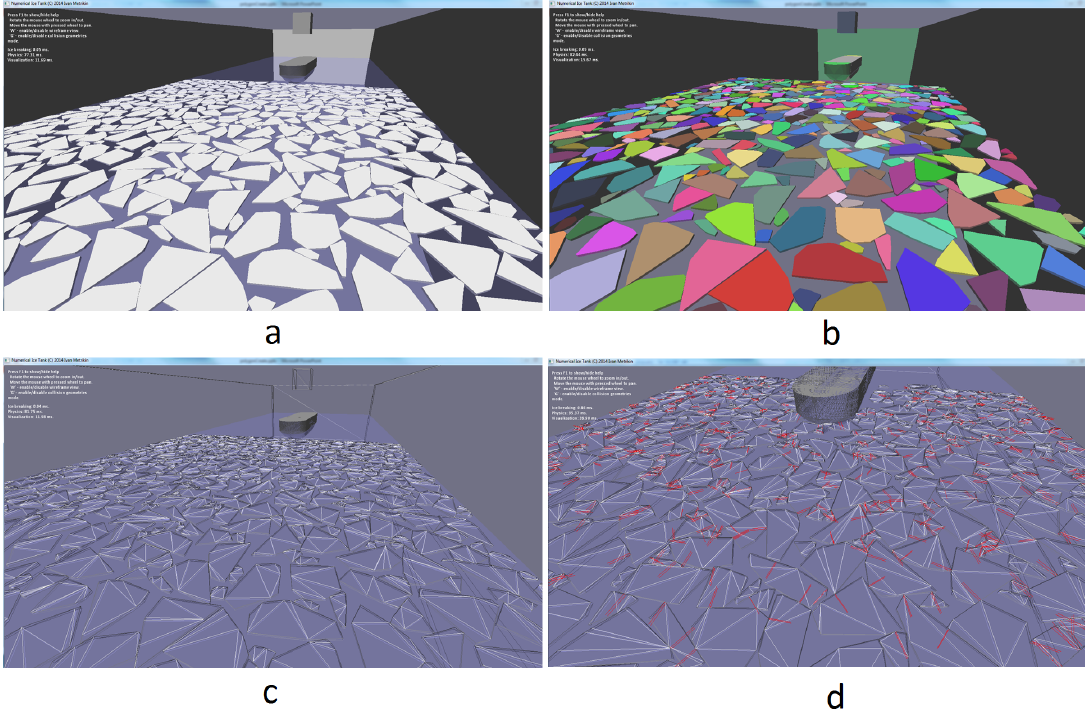
Figure 29: Visualization functionalities of the software framework. a - fluid mesh view, solid. b - collision mesh view, solid. c - fluid mesh view, wireframe. d - contact normals in wireframe